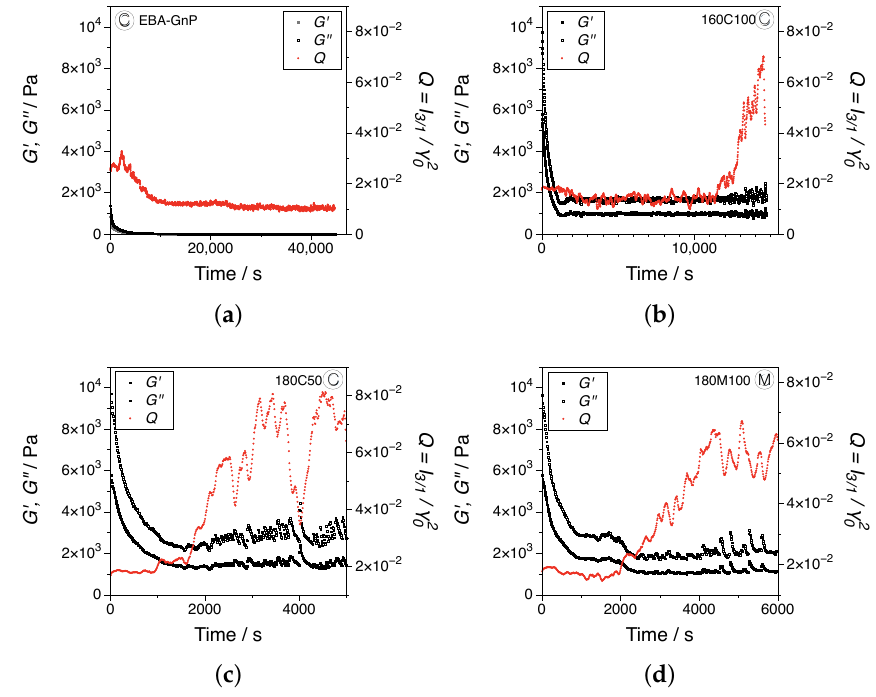
Figure 9. Transient development of the dynamic moduli and the Q -parameter in LAOS, γ = 100% and ω = 1 rad/s, for ( a ) EBA-GnP, ( b ) 160C100, ( c ) 180C50 and ( d ) 180M100. All measurements were performed at 160 ◦ C.